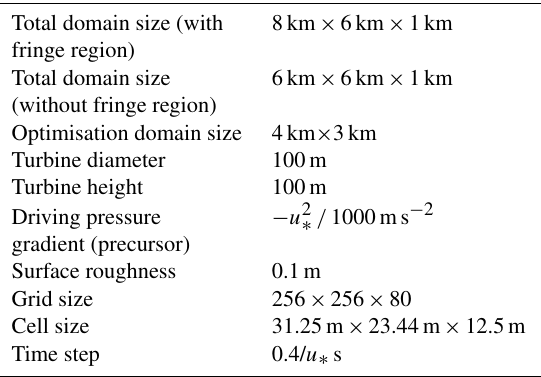
Table 1. Simulation parameters. Results remain dynamically equiv- alent for any selected value of the friction velocity u ∗ . The hub- height velocity obtained in the precursor simulation corresponds to u h ≈ 17.5 u ∗ .